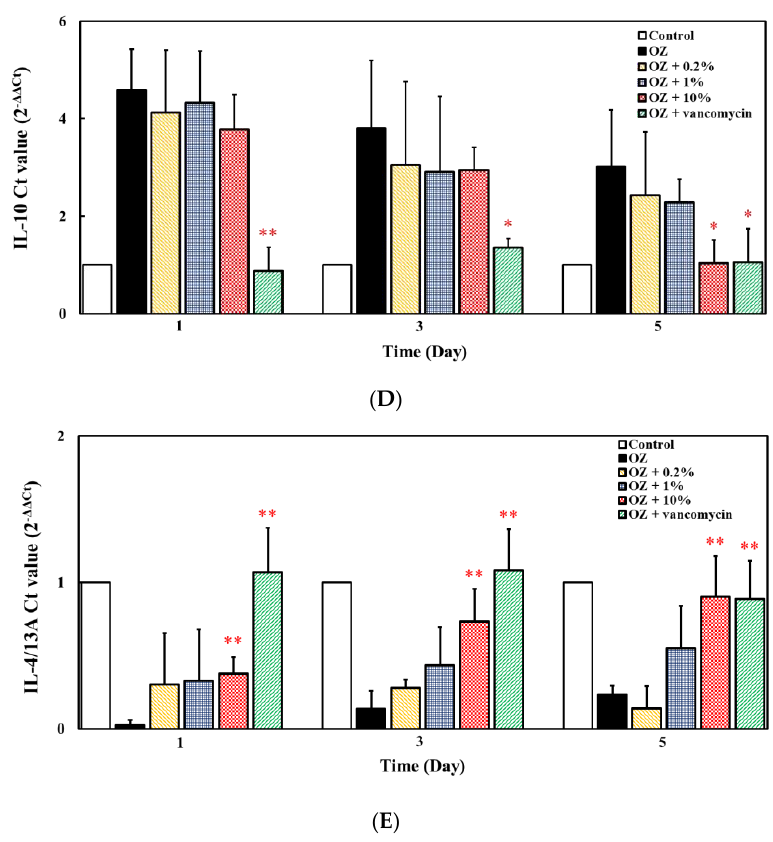
Figure 6. Effect of ACEW supplementation on gene expression of inflammation-associated cytokines in zebrafish under the intestinal stimulation by oxazolone in therapeutic mode experiment. To each group of 10 adult zebrafish, 0.2% oxazolone were intrarectally instilled to induce acute enteritis. After 5-hr induction, fish were fed with specified diet twice a day. On day-1, -3, and -5, gene expression of ( A ) TNF-α, ( B ) IL-1β, ( C ) IL-6, ( D ) IL-10, and ( E ) IL-4/13A was analyzed by qRT-PCR. Significant difference of gene expression between the ACEW supplemented diet and the control diet group (group OZ without ACEW addition) was denoted as * p < 0.05, ** p < 0.01, and *** p < 0.001.